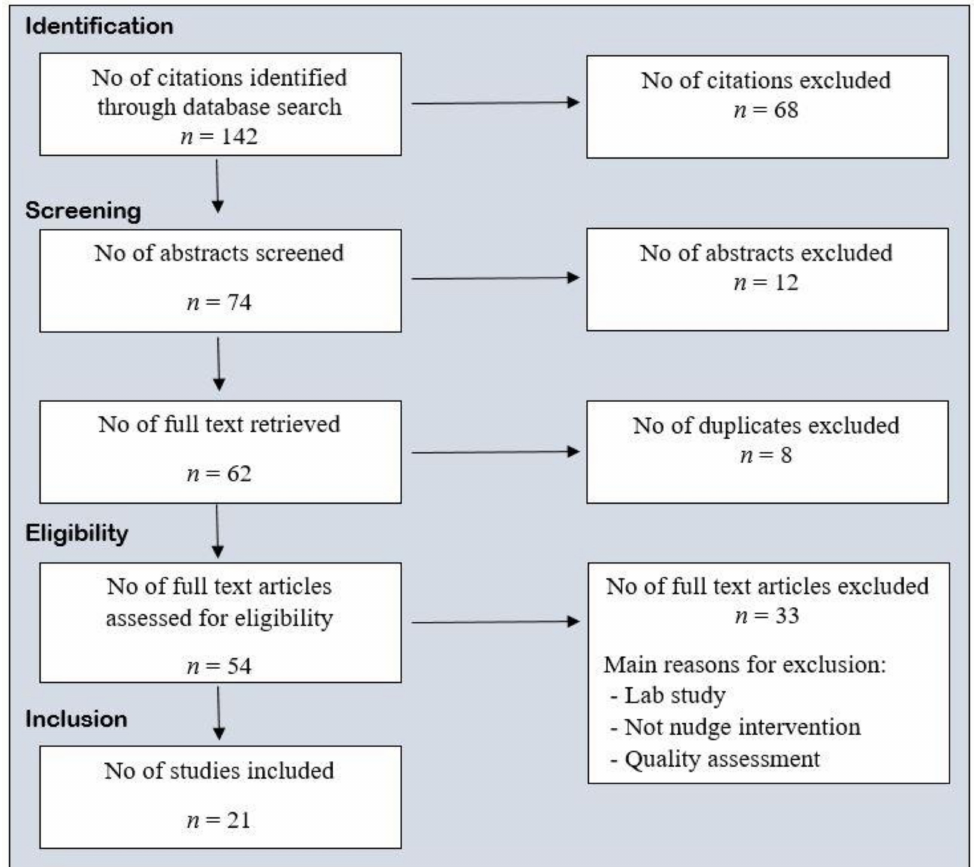
Figure 1. Flow of studies through the di ff erent phases of this systematic review.